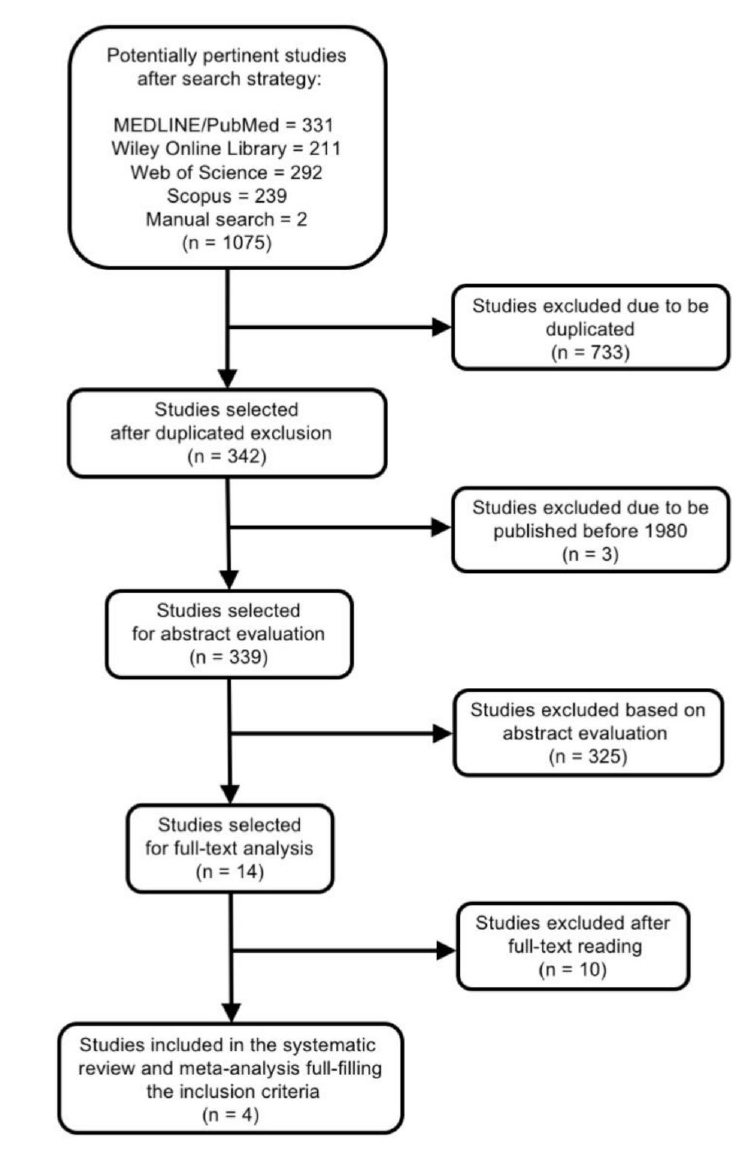
Figure 1. Selection process of the studies included in the systematic review and meta-analysis. Table 1. Studies excluded in the systematic review of association between smoking habits and the prevalence of radiolucent periapical lesions (RPLs) in root-filled teeth (RFT). Excluded reason, authors, and year of these